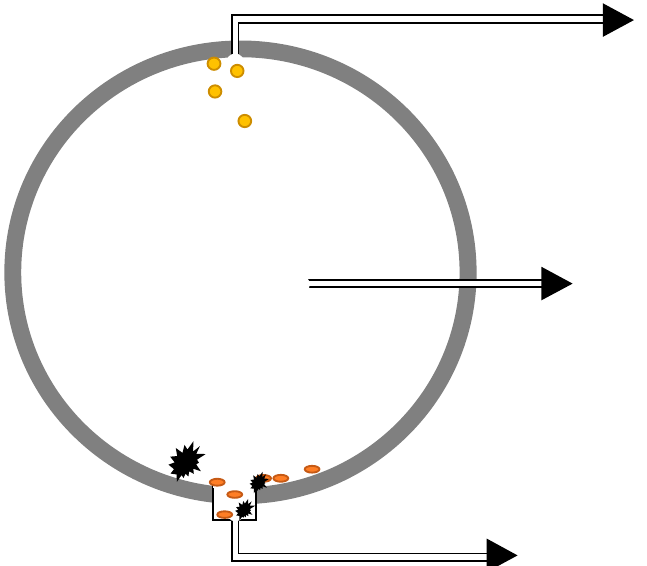
Figure 4. Schematic drawing indicating possible sample locations in a pipeline or CO 2 bulk carrier.